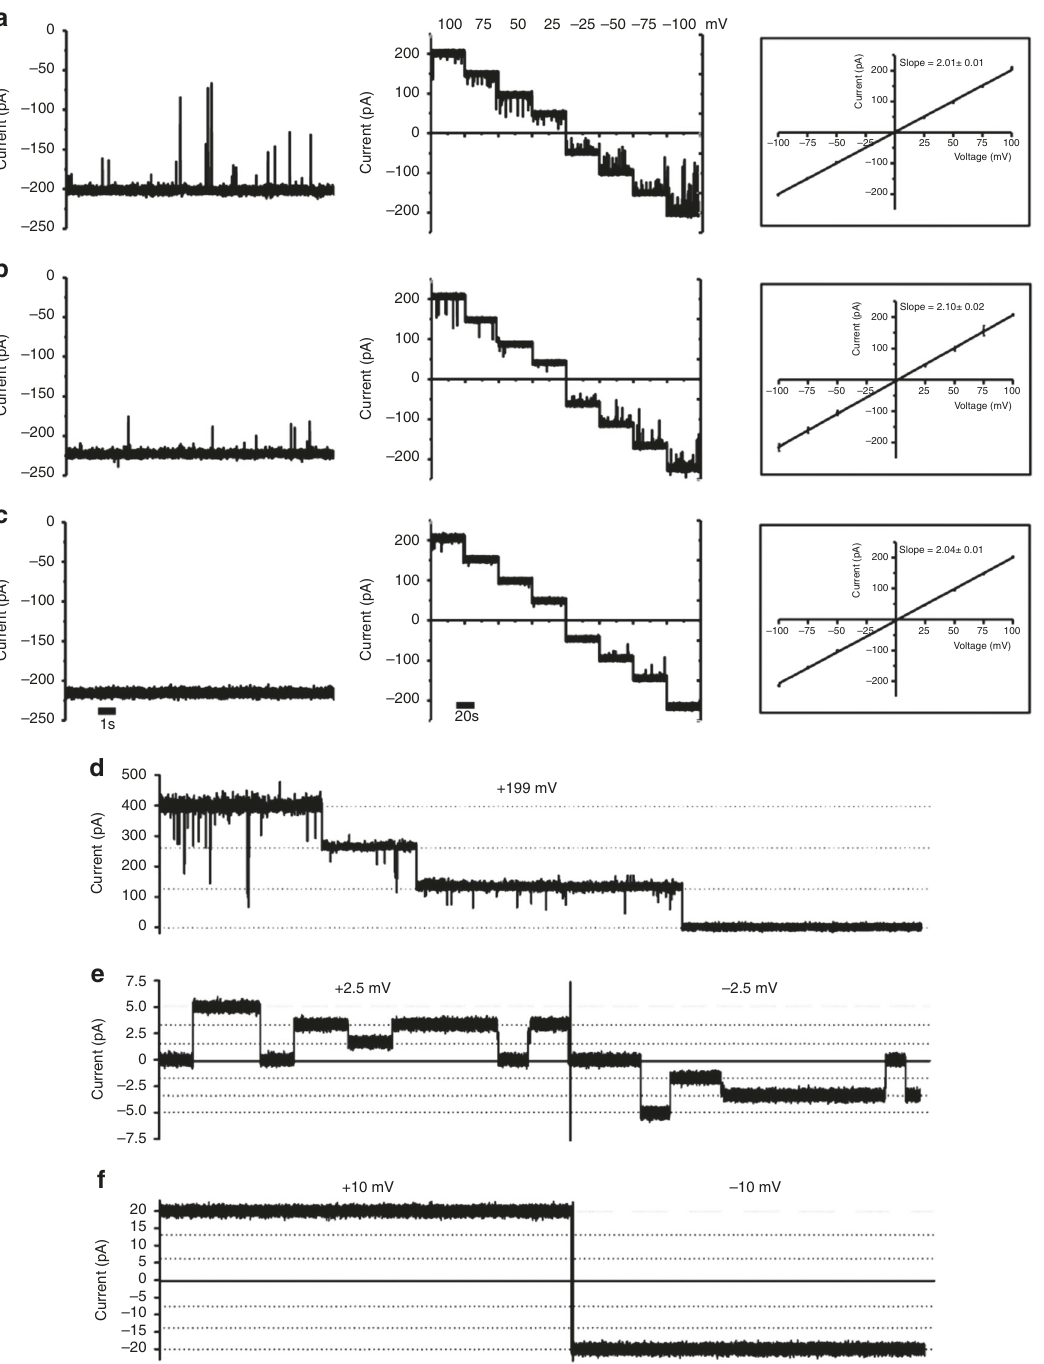
Fig. 7 Voltage-induced ejection of the pore plug in Vh ChiP. a – c Single-channel electrophysiology of OM-folded Vh ChiP ( a ), in vitro-folded Vh ChiP ( b ) and truncated Vh ChiP ( c ). Left panels show typical traces at − 100 mV, whereas the center and right panels show the current – voltage pro fi les. Data represent mean ± s.d., n = 3. d Stepwise voltage-induced closure of OM-folded Vh ChiP channels at 200 mV. e , f Typical traces observed at ± 2.5 mV ( e ) and at ± 10 mV ( f ). The data shown in d – f are for the same experiment, with protein only added at the start ( d) . Traces shown are representative of three independent